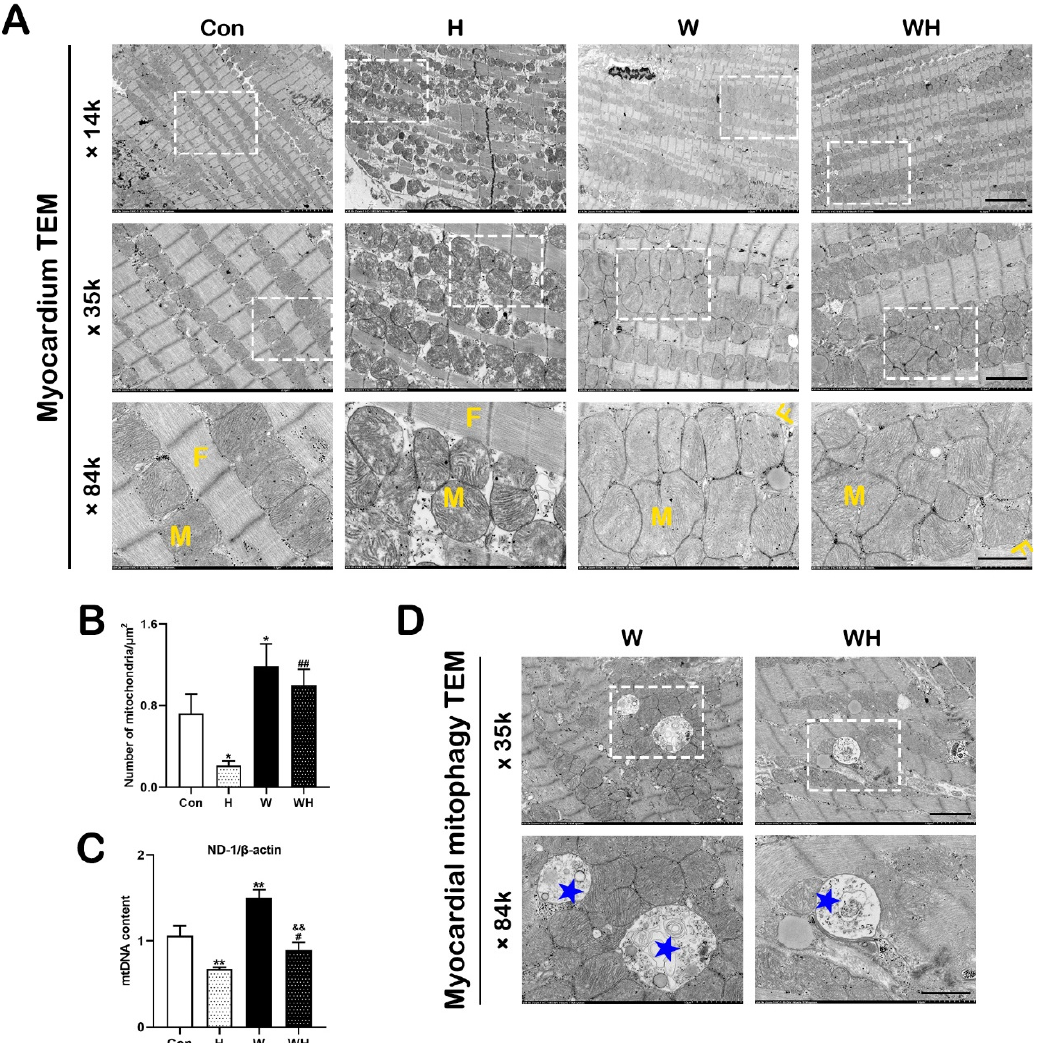
Figure 3. WA increased the mitochondrial number and enhanced autophagic flux in myocardial tissue. ( A ) Representative electron micrograph showing myocardial fibers and mitochondria. The dashed boxes correspond to the enlarged regions. M, mitochondria; F, myocardial fibers. Scale bars = 5 μ m (14 K ×), 2 μ m (35 K ×), 1 μ m (84 K ×). ( B ) Number of mitochondria per μ m 2 . Mitochondria were counted in five randomly selected TEM visual fields per group. ( C ) mtDNA copy numbers in the myocardium, as evaluated by qPCR. ( D ) Representative electron micrograph showing autophagosomes in the myocardium in the W and WH groups, as indicated by the blue pentagrams. The values are presented as the means ± SEMs ( n = 5 animals/group). * p < 0.05 or ** p < 0.01 vs. the Con group. # p < 0.05 or ## p < 0.01 vs. the H group. && p < 0.01 vs. the W group.